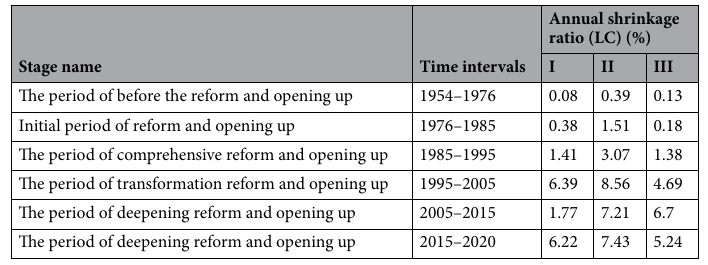
Table 5. The annual variance ratio of the marsh degradation based on the first level